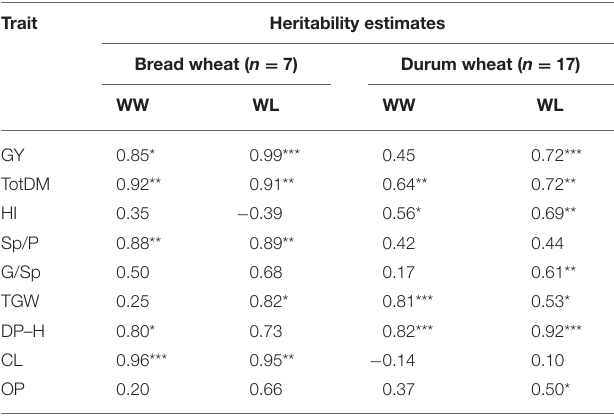
TABLE 2 | Estimated heritability for the measured traits: total dry matter (TotDM), grain yield (GY), harvest index (HI), spikes per plant (Sp/P), grains per spike (G/Sp), thousand grain weight (TGW), days from planting to heading (DP–H), culm length (CL), and osmotic potential (OP), for each ploidy level under WW, well-watered; WL, water-limited